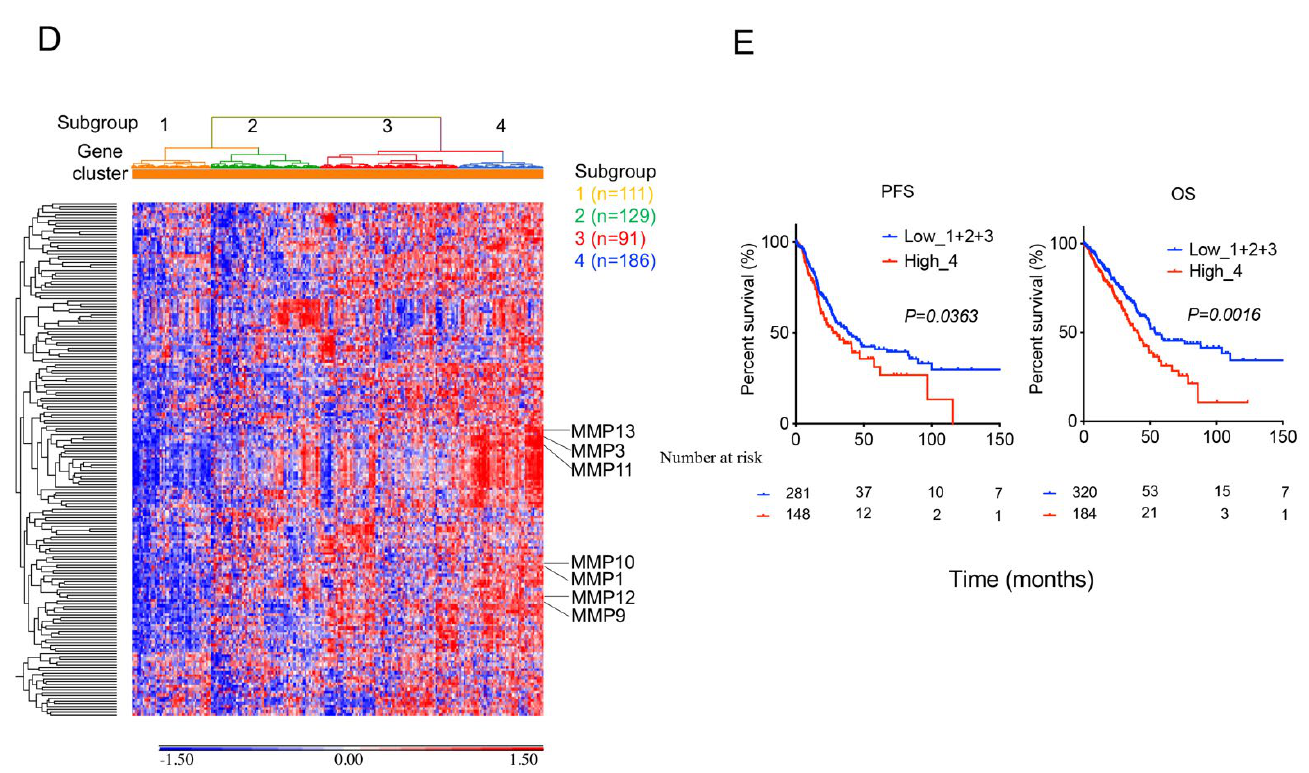
Figure 2. MMPs increase expression in lung tumors and are associated with survival outcomes in the TCGA cohort; 517 lung adenocarcinoma patient samples and 59 normal adjacent lung samples from the TCGA lung adenocarcinoma cohort were analyzed: ( A ) An unsupervised hierarchical clustering heatmap of differentially expressed genes between tumor and normal lung tissue was performed. A 185-gene cluster with enriched MMPs was identified (square). ( B ) The MMPs, including MMP1 , MMP3 , MMP9 , MMP11 , MMP12 , and MMP13 , increased expression in tumors more than normal lung tissue. TIMP-1 increased expression in tumors, but TIMP-2 , TIM-3 , and TIMP-4 decreased expression in tumors compared with normal lung tissue. Data shown are mean ± S.D. **** p < 0.0001 using Student’s t test. ( C ) Ingenuity pathway analysis of the 185-gene cluster showed significant pathways. ( D ) An unsupervised hierarchical clustering heatmap revealed four lung adenocarcinoma subgroups clustered with a 185-gene cluster. ( E ) Kaplan–Meier survival analysis of patient subgroups based on a 185-gene cluster was performed using the log-rank